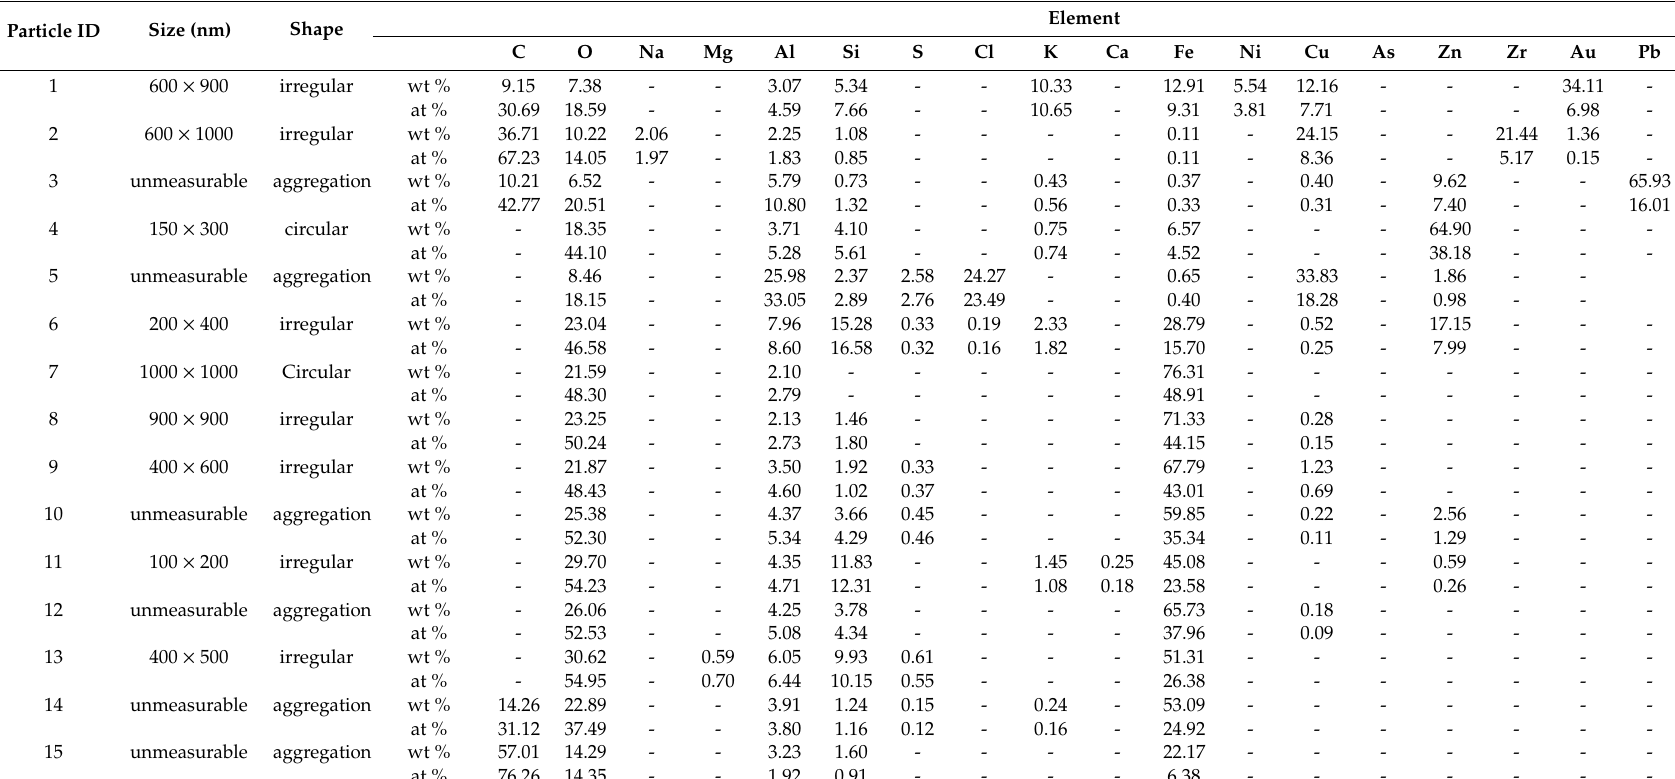
Table 1. Information about Au-, Pb-, Zn-, Cu-, and Fe-bearing nanoparticles in soils over gold